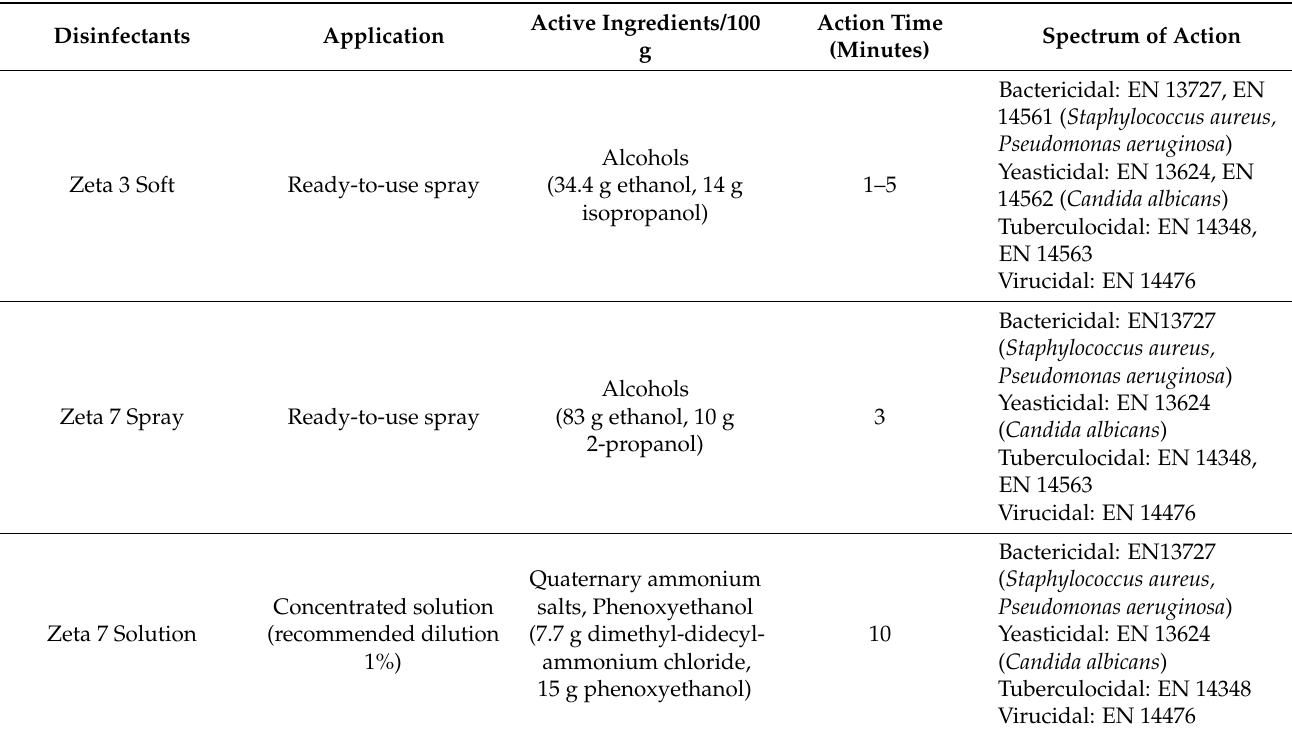
Table 2. The used-disinfectant properties, according to the manufacturer (Zhermack ®